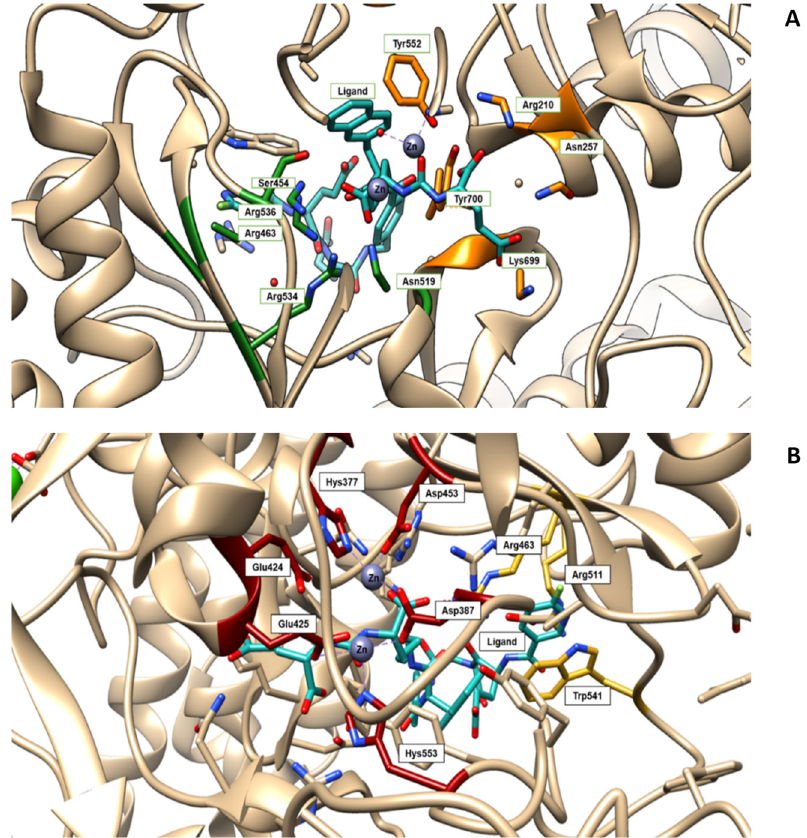
Figure 7. ( A ) Amino acids of the active site of the PSMA enzyme (GCPII) interacting with the ligand PSMA 1007 (PDB code 5O5T, in light-blue). S1 pocket (‘’non-pharmacophore pocket’’) with its argi- nine patch is indicated in green. It is specific for binding to the NAA (N-acetyl-aspartyl-) portion of NAAG (or the NAA-like- portion of PSMA-i) through polar or nonpolar interaction [112]. In orange is highlighted the S1 ′ pocket, which specifically binds C-terminal glutamate residue. S1 is a flexible funnel specific for negatively charged amino acids which improve the interaction between PSMA and their inhibitors; its flexibility enables the binding of a variety of groups, which are not essential to the determination of the affinity [113]. ( B ) The active site of the PSMA receptor in which amino acids deputy to stabilize zinc ions are colored in red, whereas the side chains of Arg463, Arg511 and Trp54, forming the “arene-binding site”, are colored in yellow. The latter define the entrance of GCPII [114]. The images are created using UCSF Chimera 1.14.